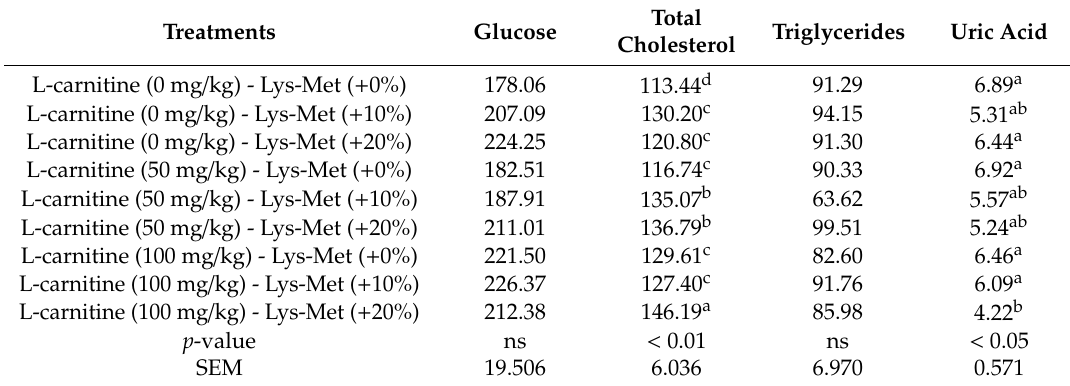
Table 7. Blood constituents (mg / dl) of broilers fed di ff erent levels of L-carnitine and lysine-methionine (Lys-Met).